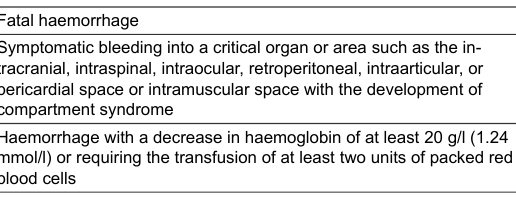
Table 1: Criteria for major bleeding as defined by the Control of Anticoagulation Subcommittee of the International Society on Thrombosis and Hemo- stasis.